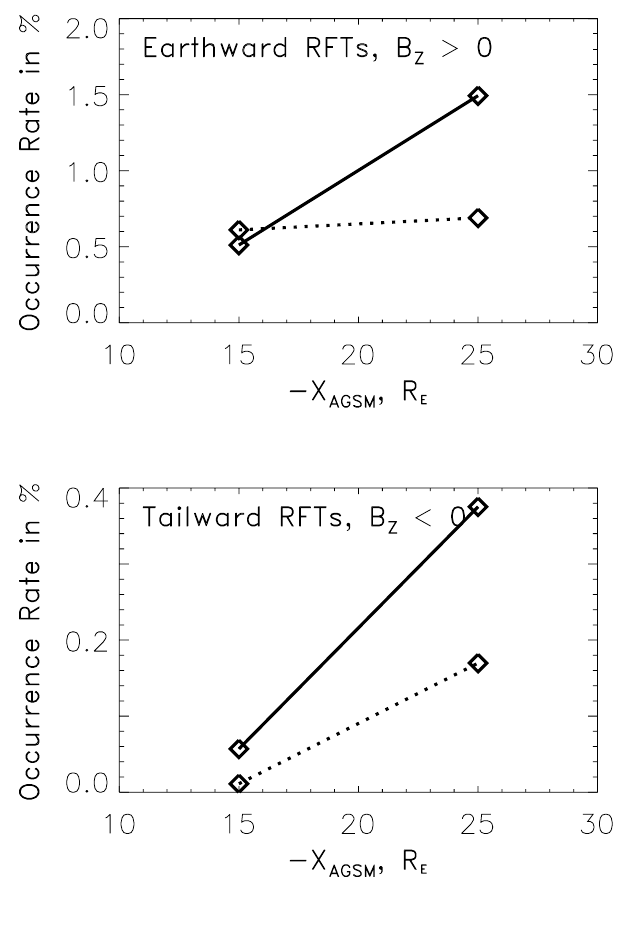
Fig. 3. Occurrence rates of earthward ( B Z > 0) and tailward ( B Z < 0) directed rapid flux transport events in the CPS. Solid lines: storm time ( D st < − 25), dotted lines: quiet